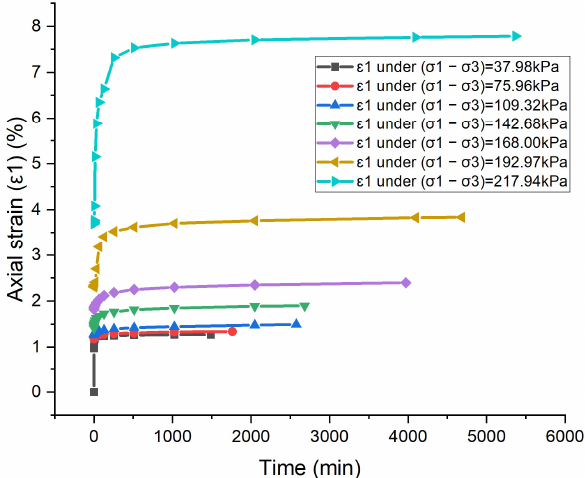
Figure 13. Axial strain (𝜀 (cid:2869) ) –time curve of No. 28, 11 FTHs.